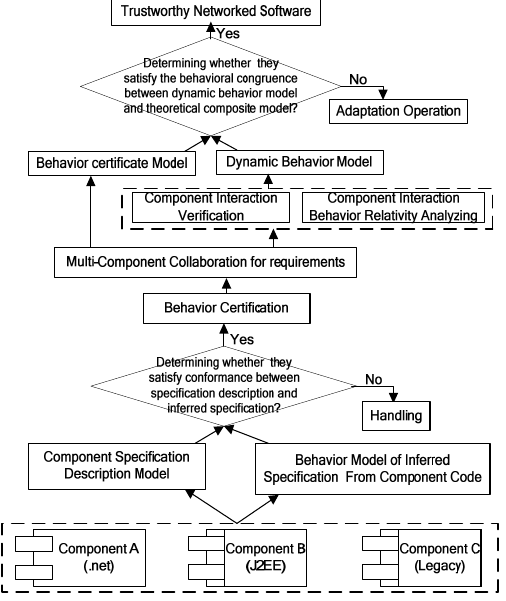
Fig. 1. The trustworthiness analyzing framework of networked